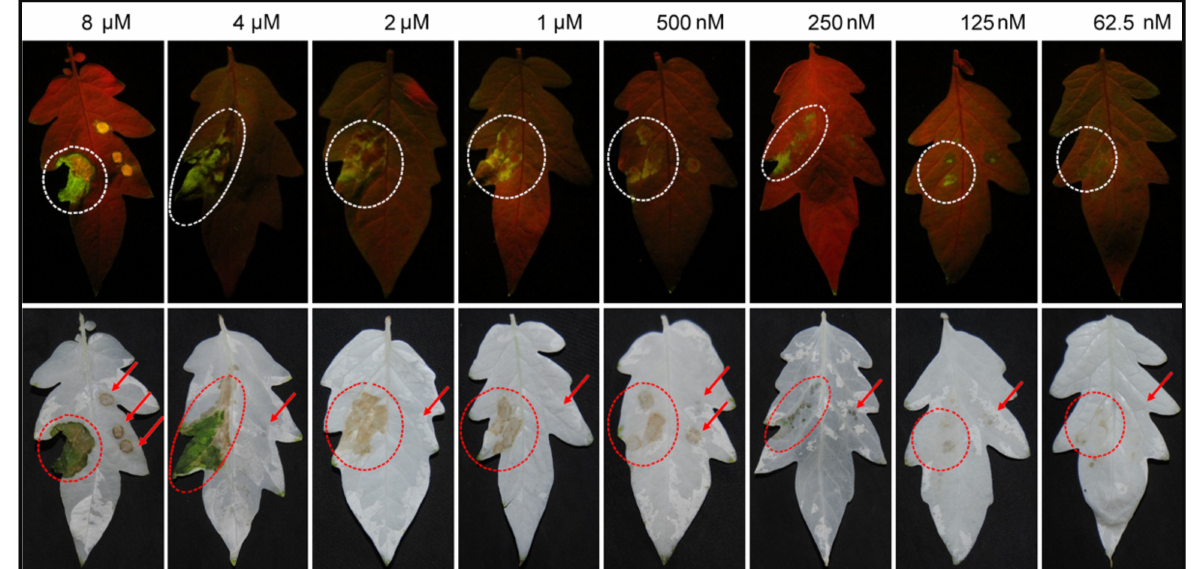
Figure 1. The recombinant SCR96 protein caused necrosis in tomato leaves. The leaves of tomato cultivar L402 were infiltrated with the recombinant protein solution and photographed at 12 h post- infiltration under UV light (upper panel) and under natural light after ethanol destaining (lower panel). The dotted circles on the left sides of the leaves indicate the lesions caused by SCR96. In contrast, concurrent infiltration with PBS on the right sides did not produce a host response. Dot traces (indicated by arrows) on the right sides of the leaves were occasionally visible (i.e., 8 µ M and 500 nM panels), which were caused by the syringe orifices without needles during the infiltration